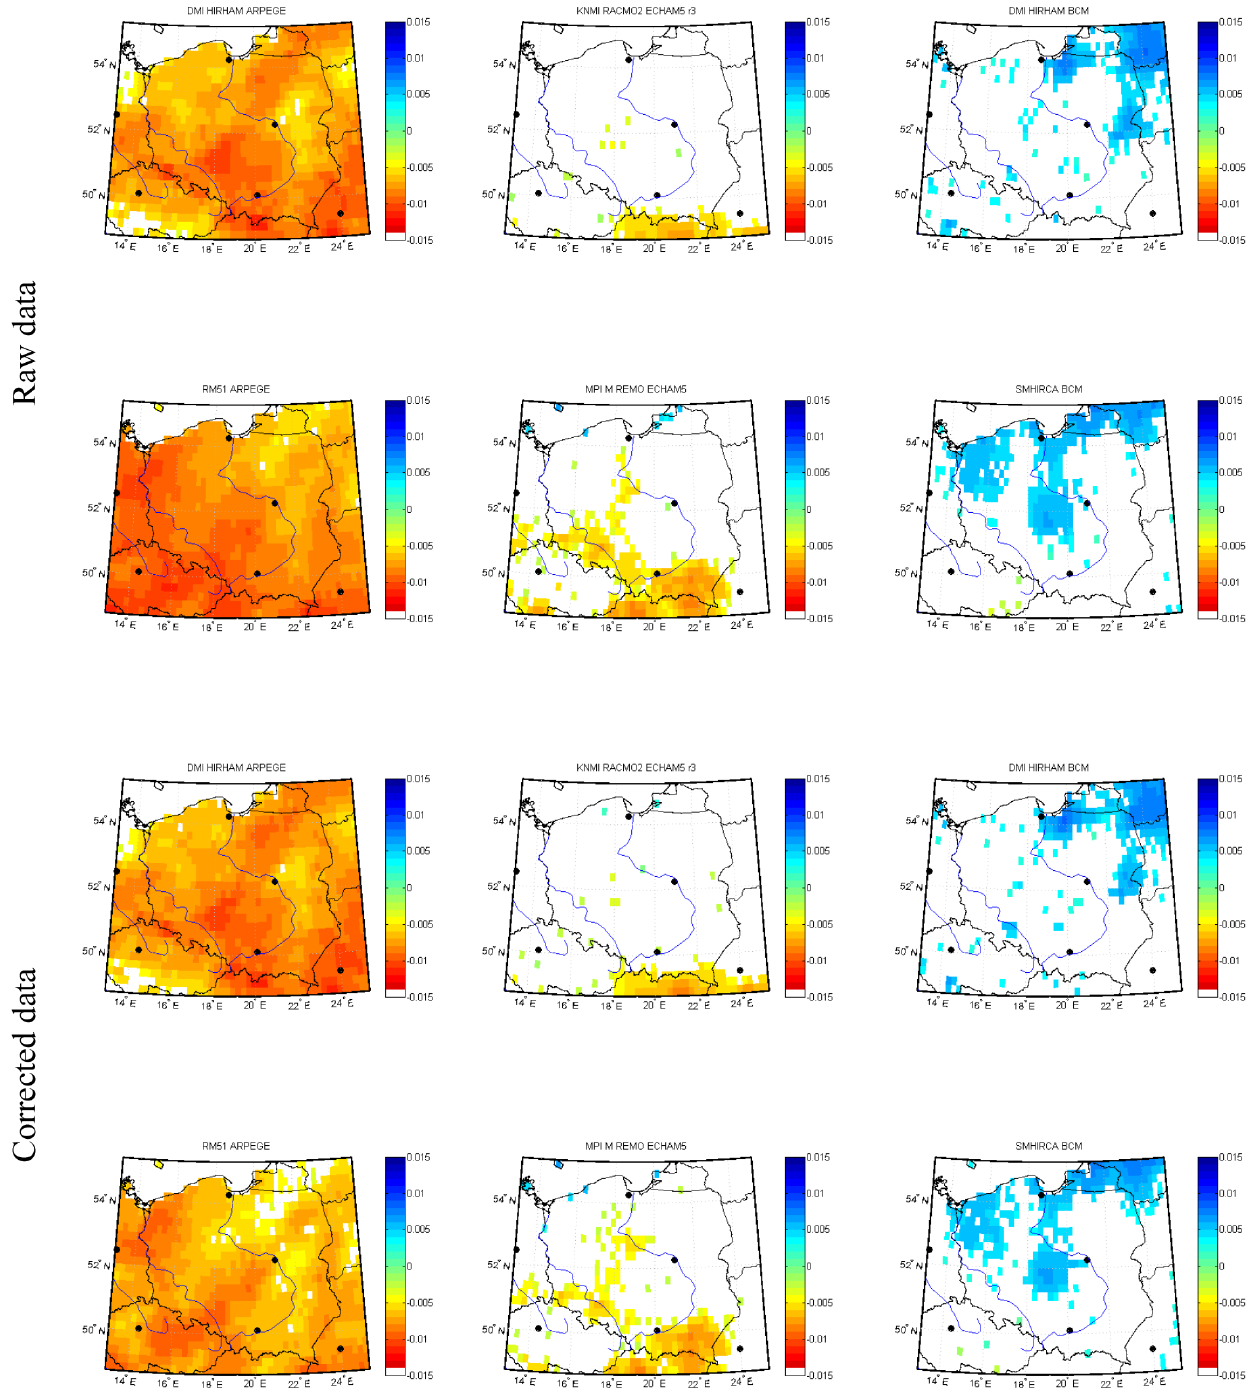
Figure 9. Results of the modified Mann–Kendall test for SPI 1 for July. Colour scale denotes the slope of the estimated trend. White areas indicate a lack of a statistically significant